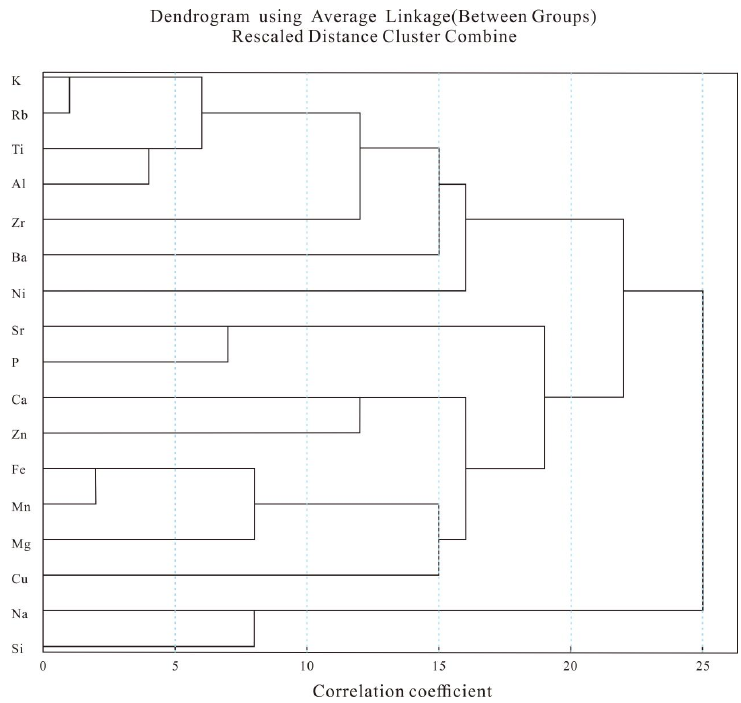
Figure 8. The cluster analysis diagram (R-type) of the elements in the Paleocene rock samples in the Lishui Sag